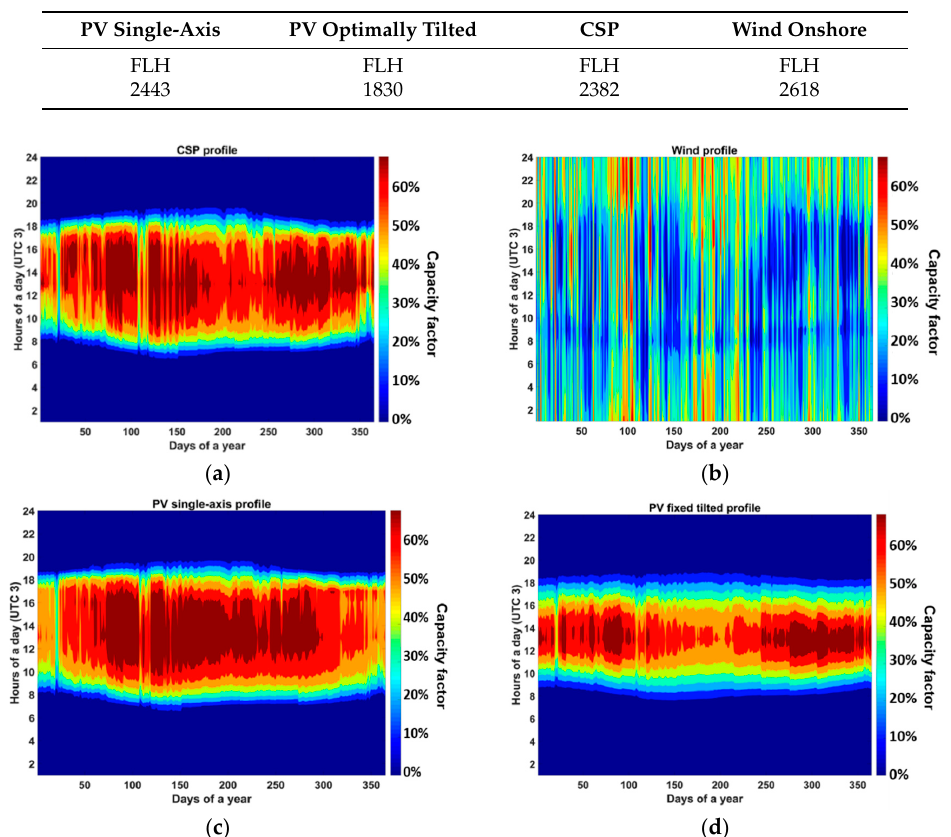
Figure 5. Aggregated feed in profiles in KSA for CSP solar fields ( a ), wind power plants ( b ), single-axis tracking PV ( c ) and optimally tilted PV ( d ). Table 4. Average full load hours (FLH) for CSP solar field, PV optimally tilted, PV single-axis tracking and wind onshore power plants in Saudi Arabia.